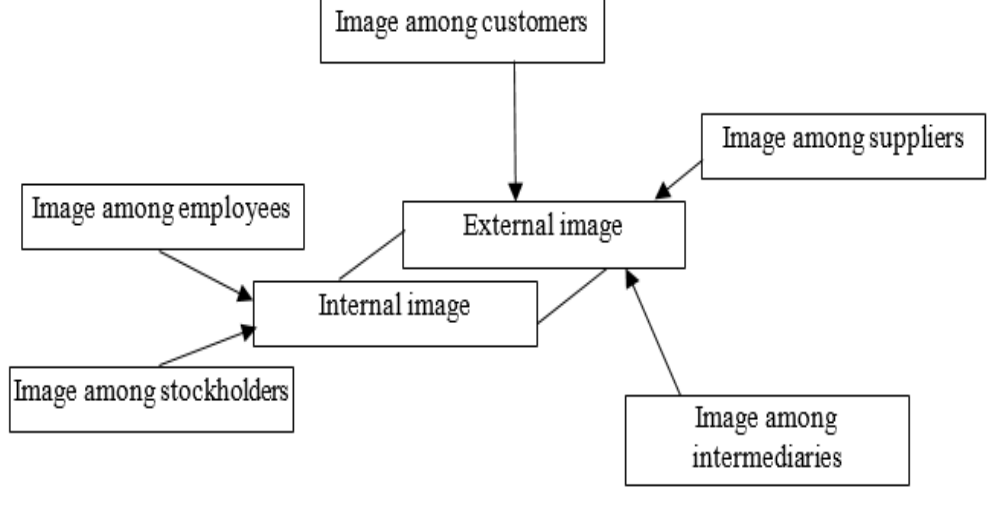
Fig. 4. The structure of business entities’ corporate image through behavioral marketing Source: Compiled by the